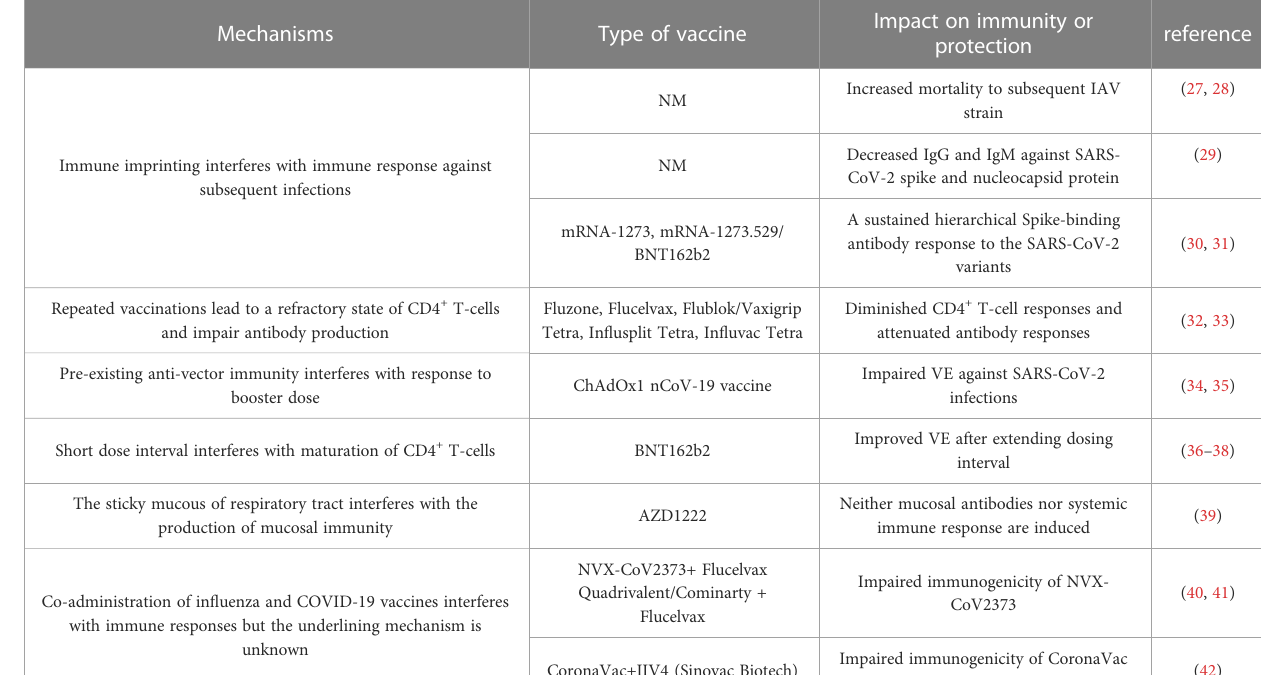
TABLE 1 Summary of immune interference in in fl uenza and COVID-19